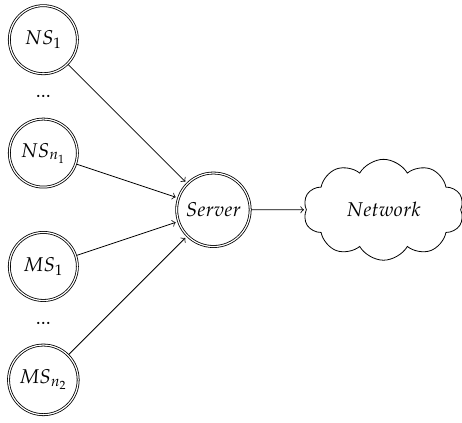
Figure 3. Network scheme for the case that there are n 1 normal stations (NS) and n 2 malicious stations (MS). NS respect 802.11 binary exponential backoff, whereas MS can choose to use it or to use a uniform backoff.